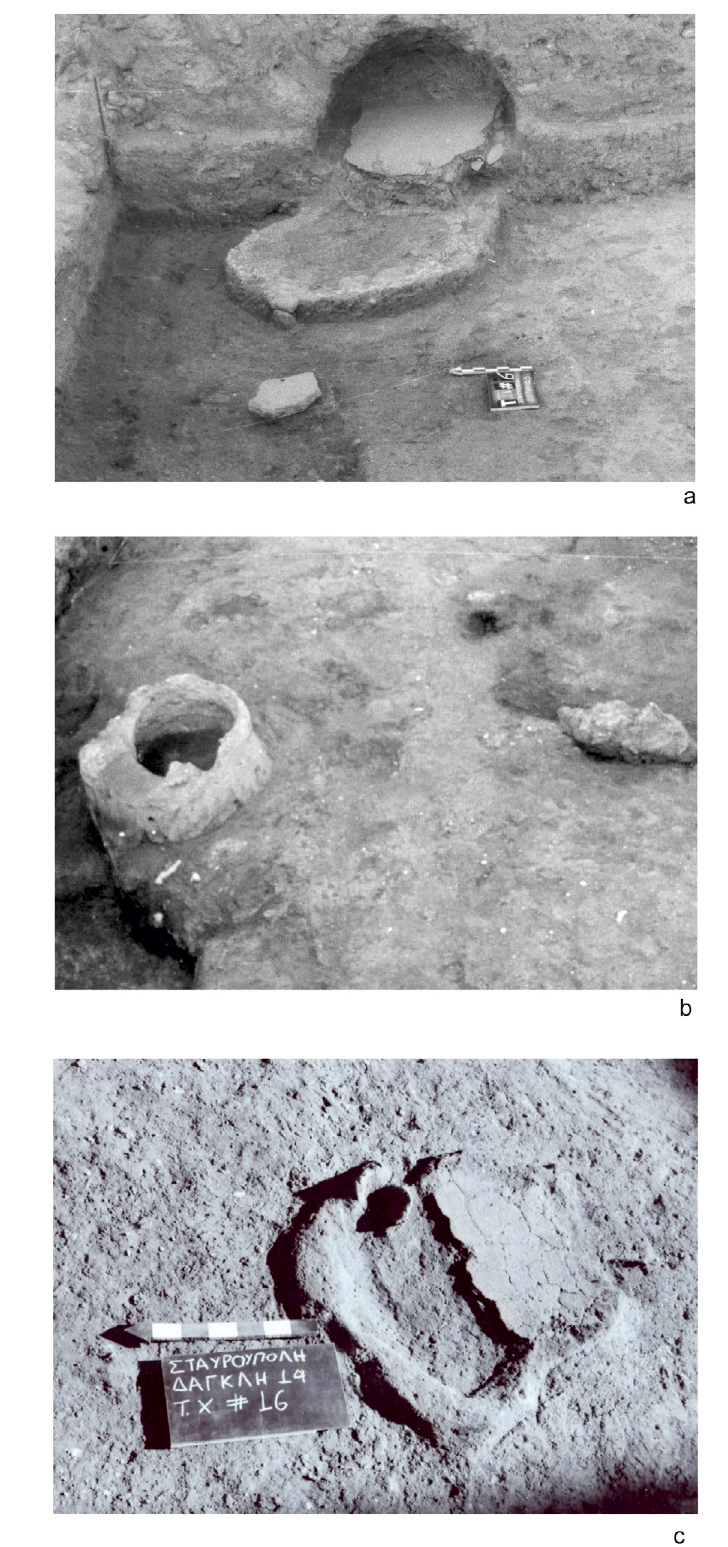
Figure 5. Ovens from Stavroupoli. a, c) possibly doomed ovens with small paved surface in front of the opening, b) oven comprised of low upright